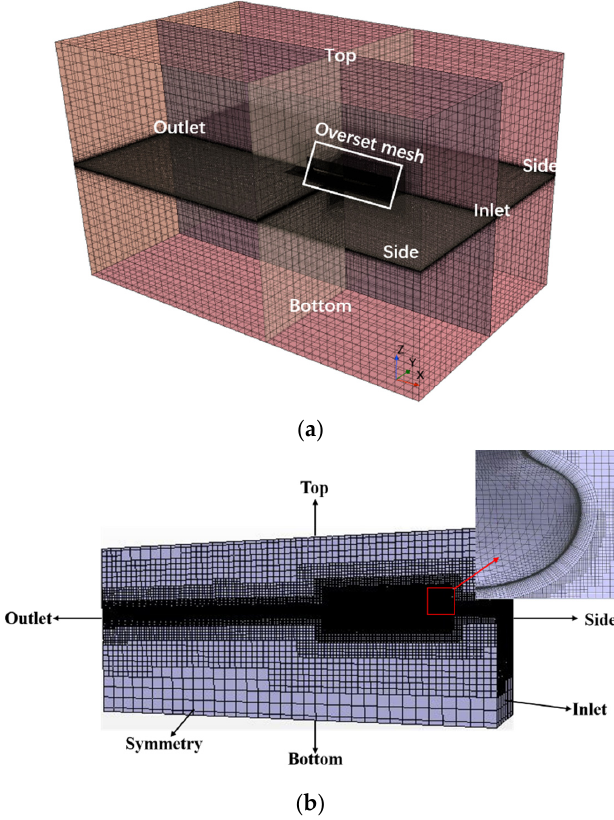
Figure 8. Mesh diagram. ( a ) Full calculation domain; ( b ) Semi-computational domain.